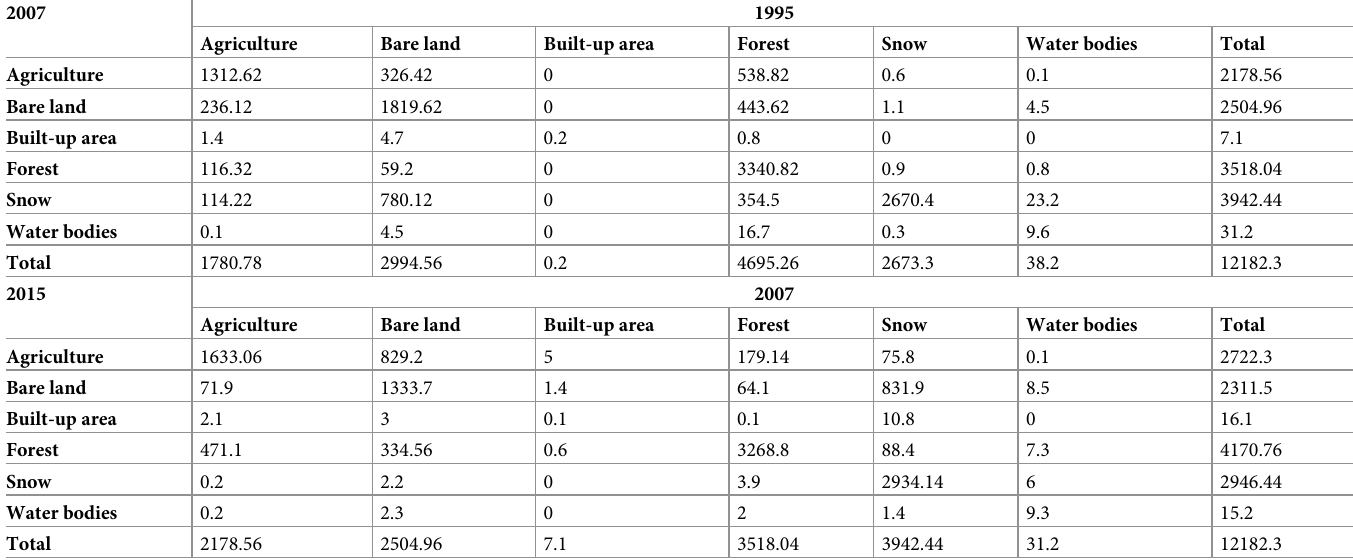
Table 5. Land use change matrix of the study area (1995–2007 and 2007–2015) (Area in km 2 ).